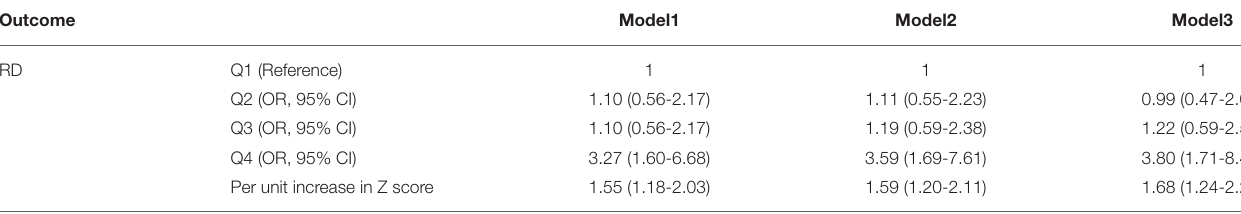
TABLE 2 | Risk ratios for clinical outcomes according to quartiles of ANGPTL8.